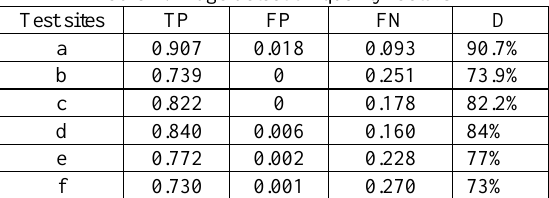
Table 1. Ridge detection quality